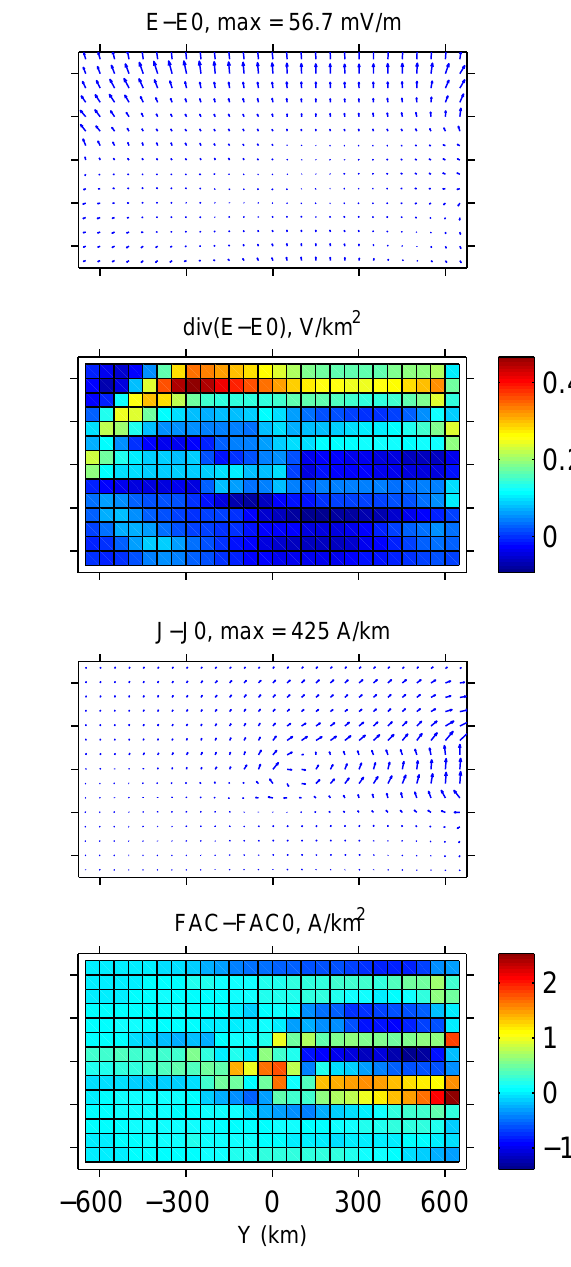
(Eq. 8) that makes better use of the information contained